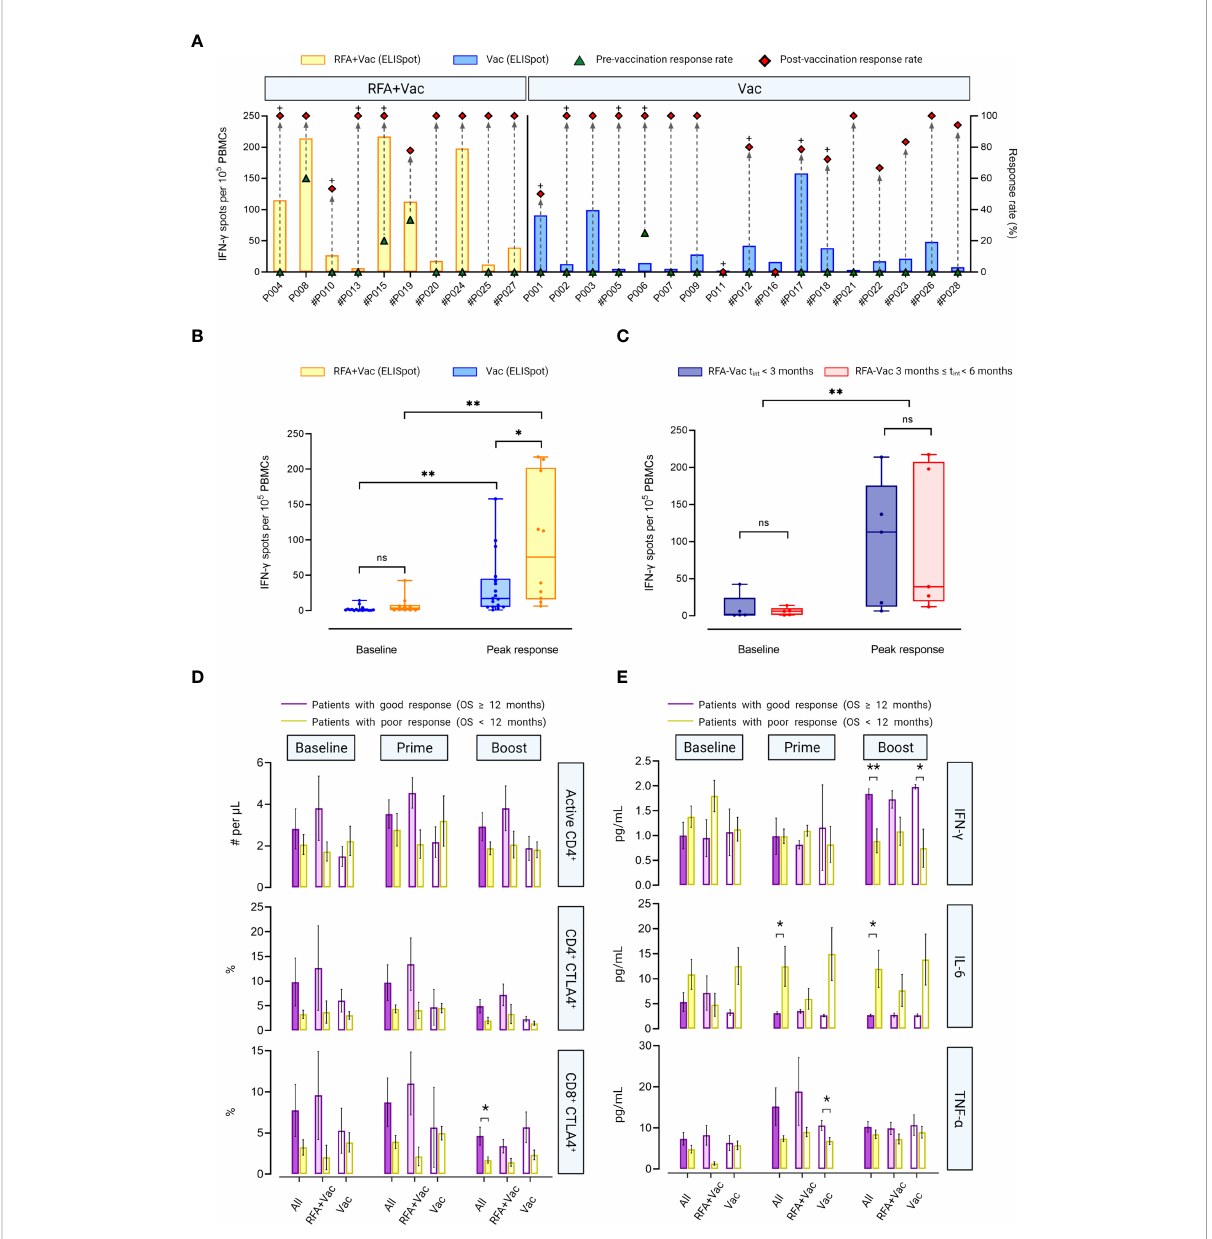
FIGURE 3 RFA+Vac patients showed better immune responses upon receiving iNeo-Vac-P01. (A) Ex vivo ELISpot assay results of each patient. Green triangle and red diamond represent the relative response rate, calculated per the ratios of peptides with positive ELISpot reads to all peptides immunized before and after vaccination, respectively. The bar chart shows the spot numbers of the peptide or peptide pool with best reads per 10 5 PBMCs. # Indicated that peptide pools were used for ELISpot assay for this patient; + indicated that relatively high abundant novel clones of peripheral T cells were detected for this patient after vaccination. (B , C) Data shown in Box and Whiskers (with minimum to maximum, showing all points and median). (B) Baseline and post-vaccination ELISpot spot counts per 10 5 PBMCs of RFA+Vac (yellow) and Vac (blue) patients. c ) ELISpot spot counts per 10 5 PBMCs at baseline and post vaccination of the peak response for RFA+Vac patients with t int < 3 months, or 3 ≤ t int < 6 months. No signi fi cant difference was found between the two groups at baseline (blue and yellow); however, the difference was intensi fi ed post vaccination, as patients with t int < 3 months showed stronger peak response (red). Baseline response and peak response of all RFA+Vac patients showed statistically signi fi cant difference ( p < 0.0051). (D) Flow cytometric analyses of RFA+Vac and Vac patients on T cell subsets. RFA +Vac and Vac patients were further divided into two subgroups: patients with good response (OS ≥ 12 months) and poor response (OS < 12 months); number of active CD4 + T cells (# per m L), and proportion of CD4 + or CD8 + T cells that expressed CTLA4 (%) at baseline, prime phase and boost phase were analyzed, respectively. (E) Flow cytometric analyses of RFA+Vac and Vac patients on cytokines including IFN- g , IL-6 and TNF- a at baseline, prime phase, and boost phase. A t-test analysis was applied to indicate the signi fi cance in data difference with a two-tailed p value. ns, not signi fi cant (p > 0.05); *p ≤ 0.05; **p ≤